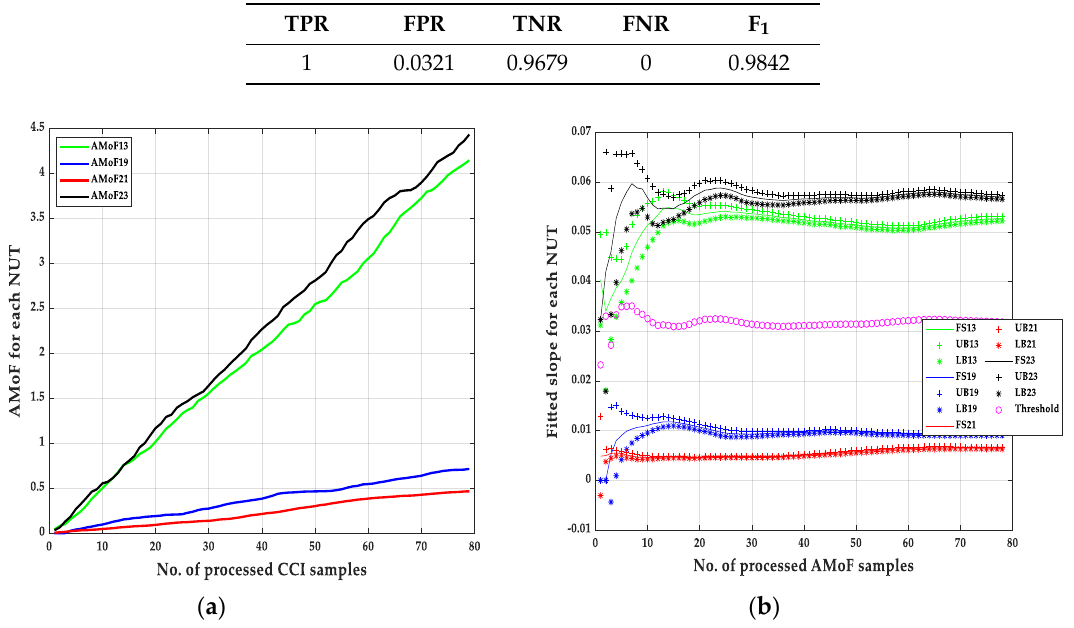
Figure 5. The AMoF and the fitted slope for different nodes for scenario NS15P7: ( a ) The AMoF for different NUT; ( b ) the fitted slope for NS15P7_FL_GM 25/5. Table 5. Performance characterization for NS15P7_FL_GM 25/5.